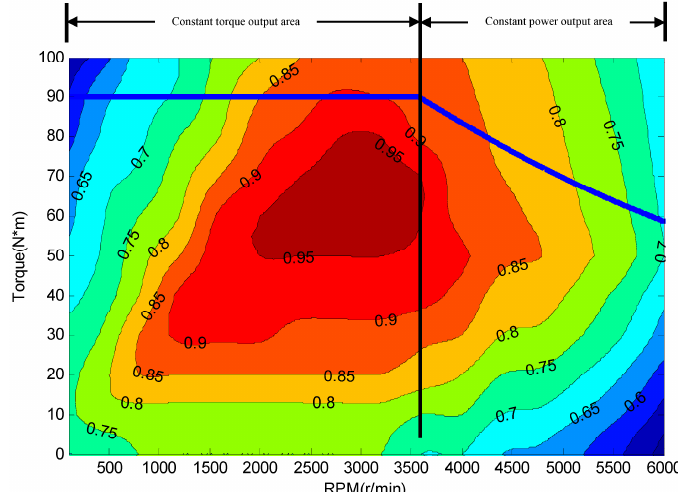
Figure 2. Motor torque external characteristics and efficiency map.